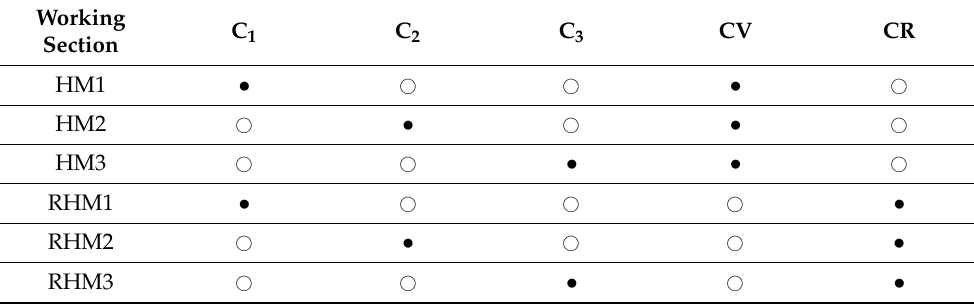
Table 1. Working states of clutches in different working sections.